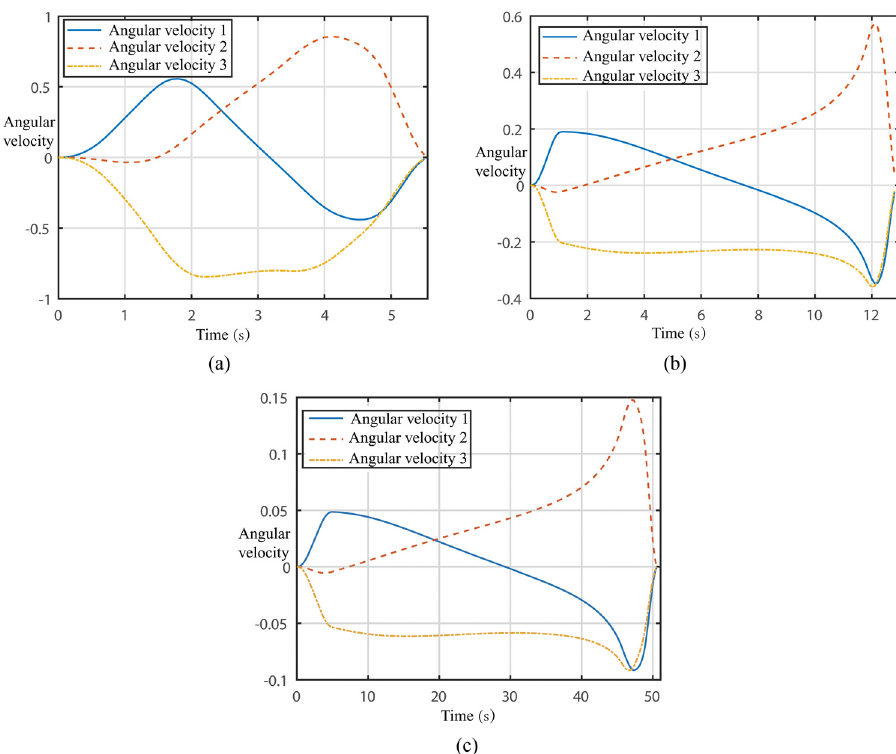
Figure 9: Joint angular velocity curves under three conditions. ( a ) Condition A, ( b ) condition B, and ( c ) condition